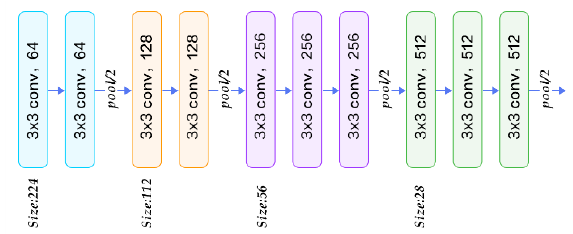
Fig. 1. The configuration of the first ten layers of neural network